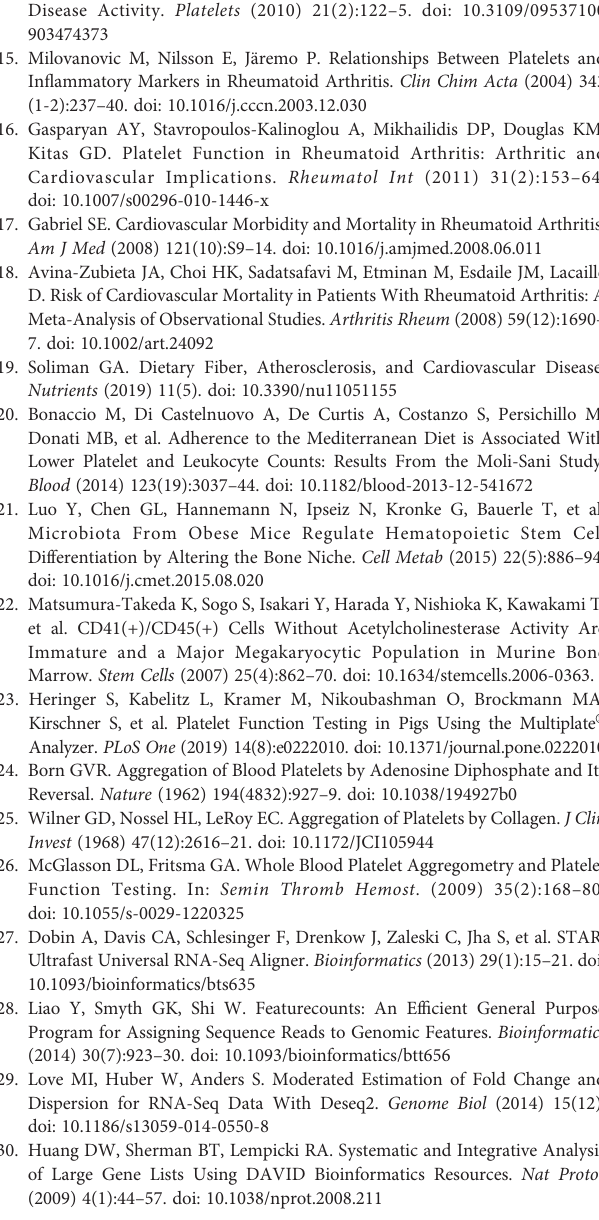
(A) Platelet count, (B) Mean platelet volume (MPV) and (C) Mean platelet component (MPC). Erythrocyte parameters include (D) Red blood cell (RBC) count, (E) Mean corpuscular volume (MCV) and (F) Mean corpuscular haemoglobin concentration (MCHC). (G) Gene expression of CD61 in Meg-01 from RNAseq Expressed as DESeq2 normalized readcounts. Data are expressed as the mean ± sd. Statistical difference was determined by Student ’ s t-test. **p <